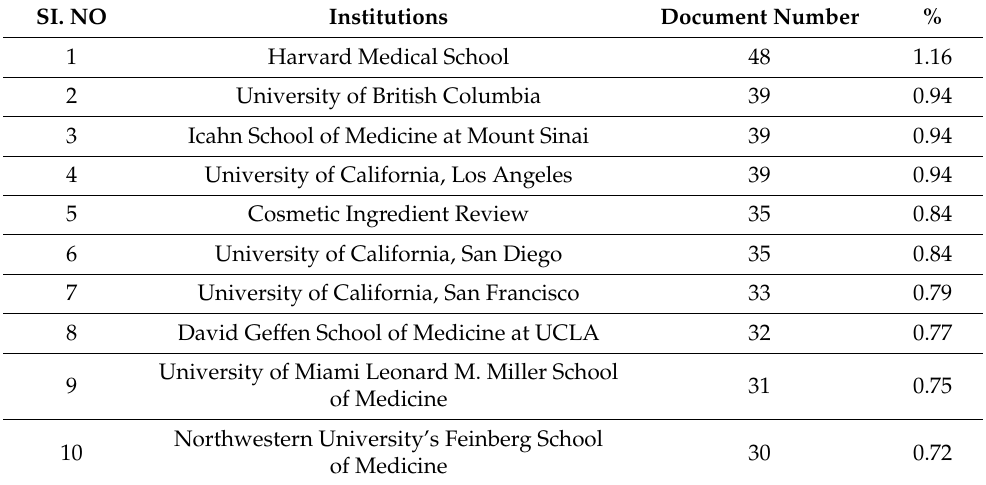
Table 4. The top ten institutions by number of publications in the literature related to cosmetic adverse effects literature.